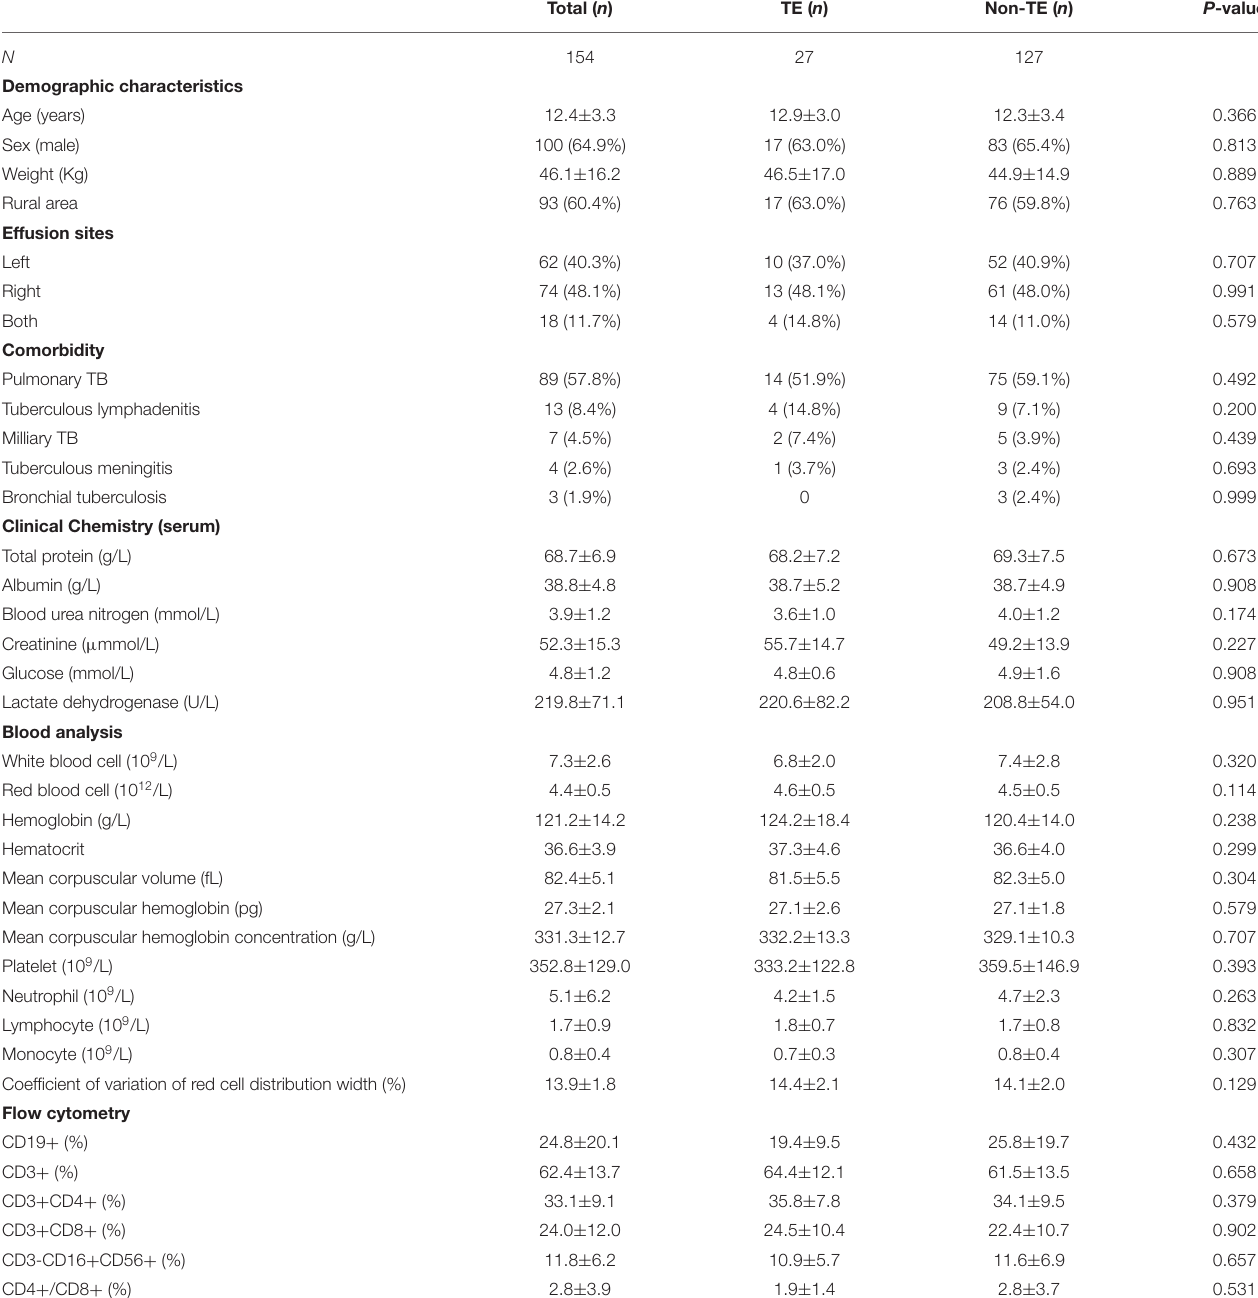
TABLE 2 | Univariate analysis of the demographic data associated with TE in childhood pleural TB. Total ( n ) TE ( n ) Non-TE ( n ) P